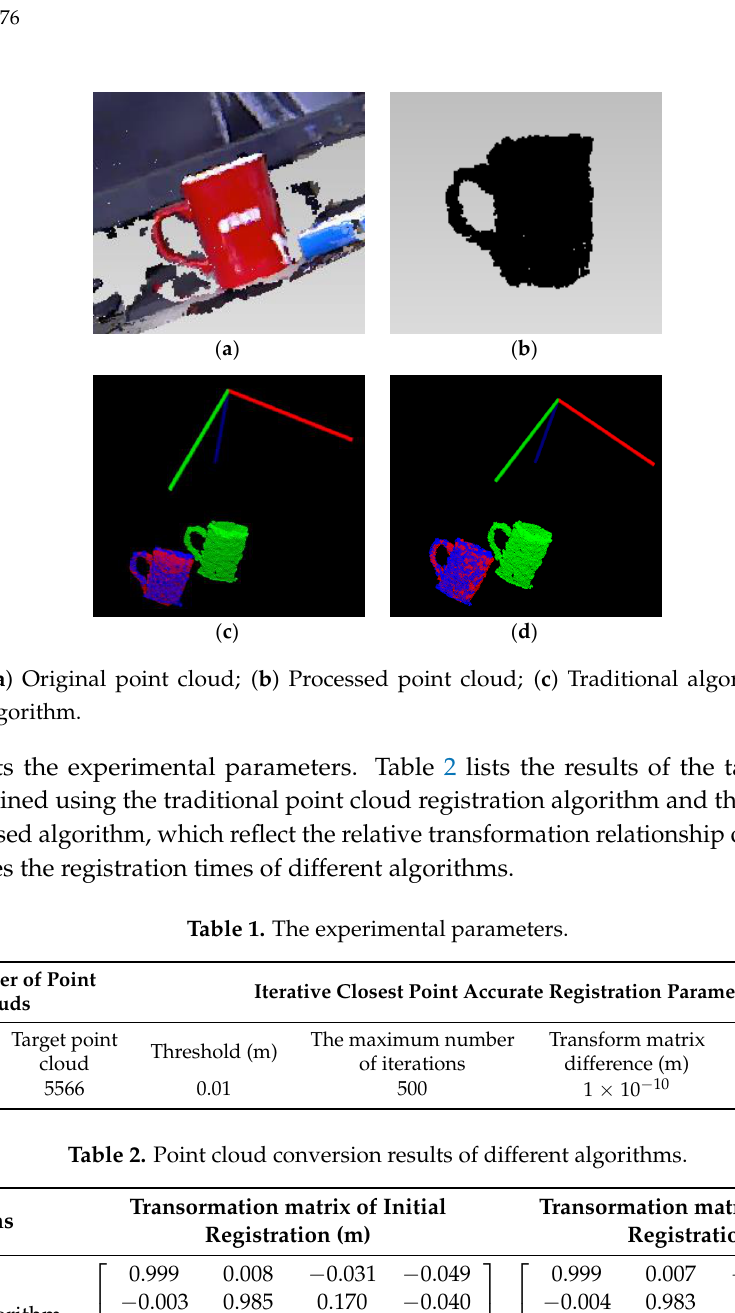
Table 1. The experimental parameters.